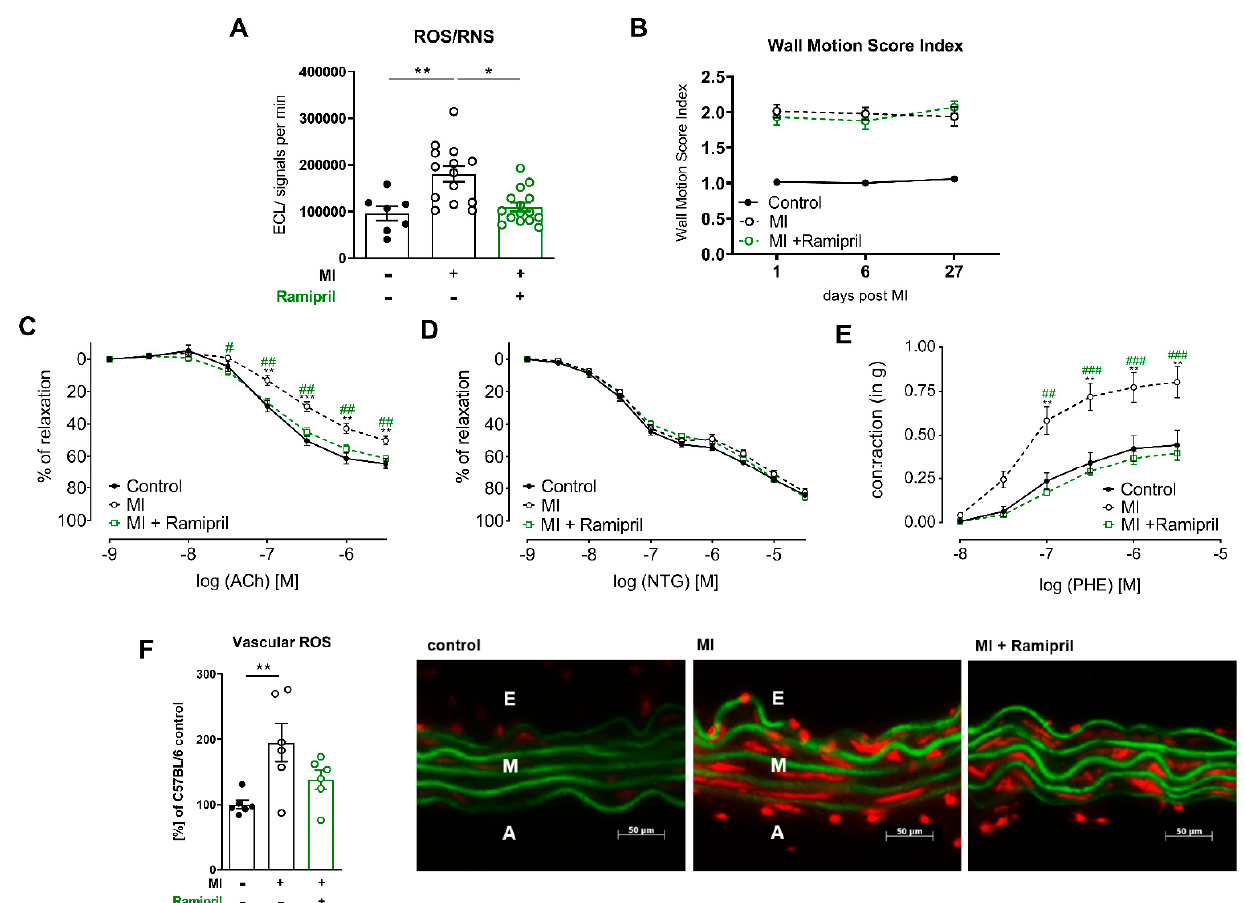
Figure 3. In ischemic heart failure, early ACE inhibitor treatment improves vascular endothelial function due to reduction of vascular and systemic ROS. ( A ) Superoxide formation in whole blood measured by enhanced chemiluminescence after stimulation with PDBu 28 d after MI, n = 7–15 mice per group; ( B ) High-frequency ultrasound echocardiography with measurement of wall motion score index (WMSI) 4 weeks post-MI, n = 13 to 14 mice per group; ( C – E ) Isometric tension studies of isolated aortic segments 28 d after MI. ( C ) Contraction-relaxation curves in response to endothelium-dependent vasodilator acetylcholine (Ach), ( D ) contraction-relaxation curves in response to endothelium-independent vasodilator nitroglycerin (NTG), ( E ) dose-dependent contraction curve in response to the α 1-agonist phenylephrine (PHE); n = 4–12 rings per group; mean + SEM; 2-way ANOVA; * p < 0.05, ** p < 0.01 (Control vs. MI), # p < 0.05, ## p < 0.01, ### p < 0.001 (MI vs. MI + ramipril); ( F ) Oxidative fluorescence microtopography; right: per group, one representative photomicrograph is shown. Autofluorescence of laminae produces a green signal, superoxide formation yields a red fluorescent signal; A, adventitial layer; E, endothelial layer; M, medial layer; left: quantification of superoxide formation in the vessel wall measured by integrated optical density (IOD), percentage of C57BL6 sham; n = 6 per group; mean + SEM; one-way ANOVA. p < 0.05, ** p < 0.01, *** p < 0.001.